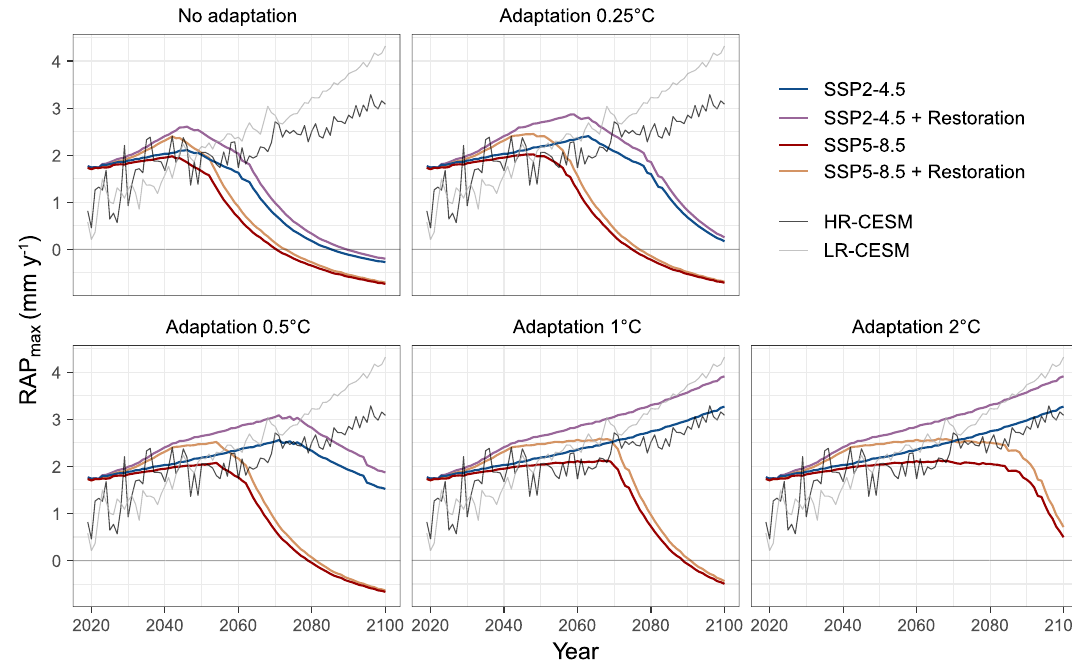
Figure 2. Mean potential reef accretion (RAP max in mm yr −1 ) projections at Cheeca Rocks from 2019 to 2100 under the SSP2-4.5 (blue) and SSP5-8.5 (red) scenarios. Panels depict RAP max rates in scenarios where no adaptation, 0.25, 0.5, 1 and 2˚C adaptation were incorporated. The purple and orange line represents vertical accretion when M:IR cover targets are incorporated in the carbonate budget projections for SSP2-4.5 and SSP5- 8.5 respectively. Trends in reef accretion are compared to SLR projections using a low- and high-resolution version of CESM (LR-CESM in grey and HR-CESM in black) (van Westen et al., 2021). The CESM SLR time series are retained near Cheeca Rocks (spatial average over 24.5 N–25.5 N and 80 W–81